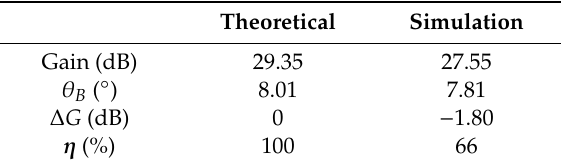
Table 7. Lens structure simulation